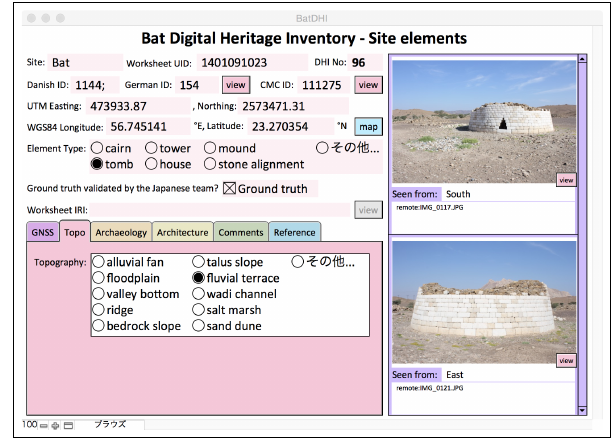
Figure 5: Interface of the ElementDHI table (Topo